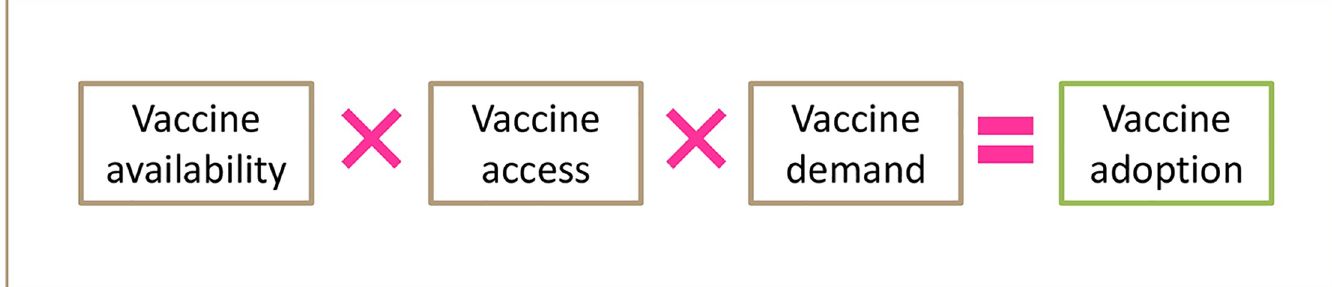
Fig 2. Vaccine adoption. Vaccine adoption is the result of vaccine availability, vaccine access, and vaccine demand [13]. Each component is required to achieve vaccine adoption. The figure assumes that the vaccine is safe and effective and that these are not limiting factors to vaccine adoption.